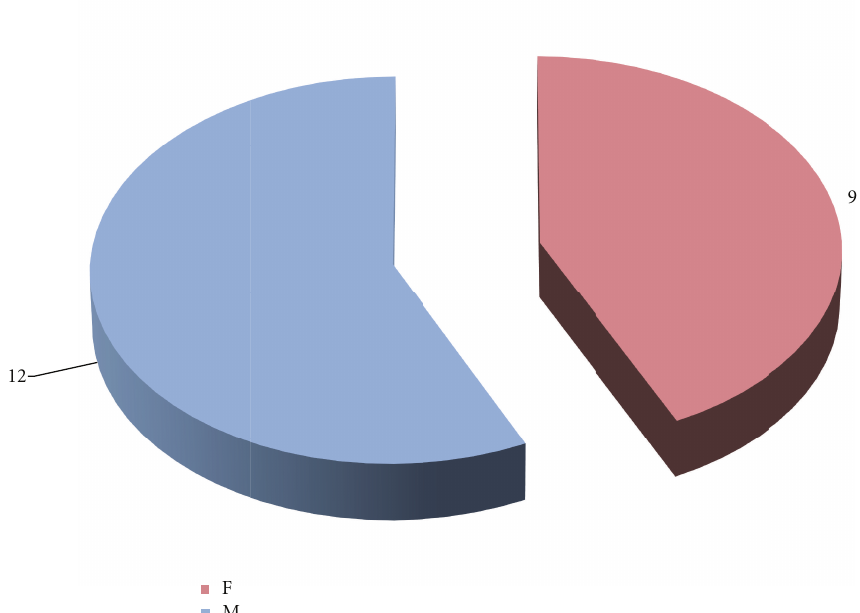
Figure 5: Distribution of gender for MOB